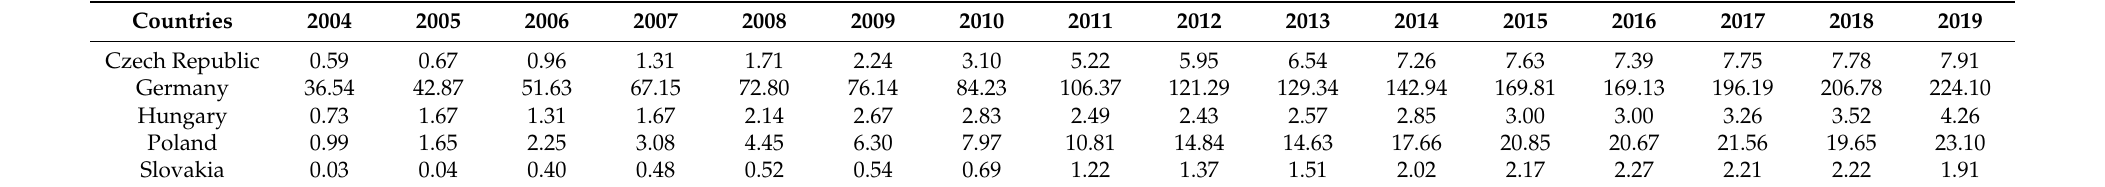
Table 2. Renewables: Renewable power generation—[TWh].